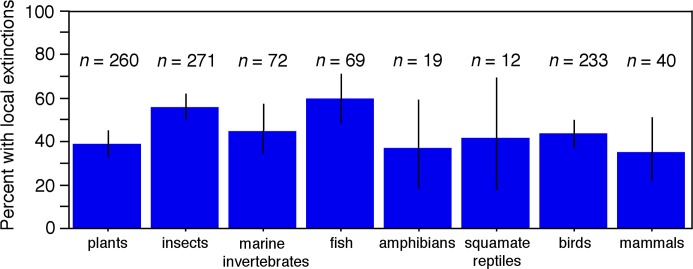
The frequency of local extinctions related to climate change across different taxonomic groups.The percentage of species with one or more local extinctions in each taxonomic group is shown, along with the total sample size of species surveyed in that group. For ease of presentation, four different groups of marine invertebrates (annelids, crustaceans, molluscs, and echinoderms) are shown together. Frequencies for these four groups were averaged to obtain a single value, and sample sizes of species across groups were summed. Squamate reptiles include lizards and snakes. Vertical lines indicate 95% confidence intervals on the estimated frequency of species with local extinctions.